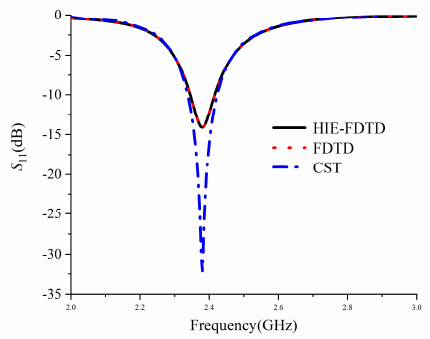
Figure 4. S 11 of the planar monopole antenna.